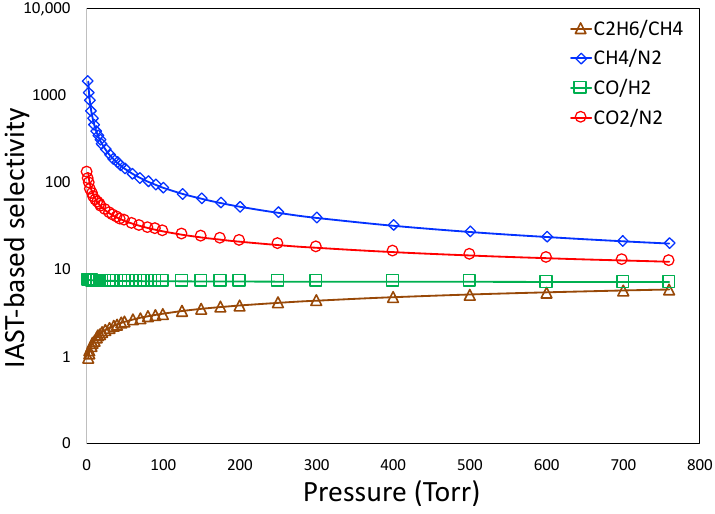
Figure 9. IAST-based selectivity for gas pairs.